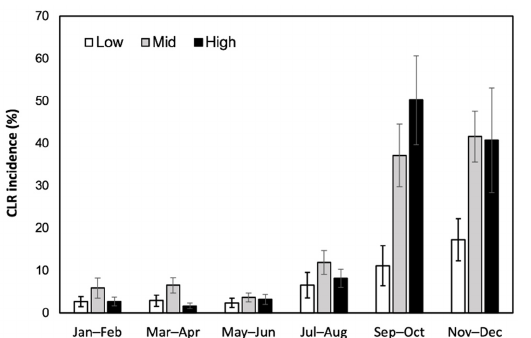
Figure 4. Mean CLR incidence across low- (200–400 m), mid- (401–600 m), and high-elevation (601–900 m) coffee lots in Kona from January–December 2021. Although a trend of lower incidence at low elevations was observed at the end of the season, this difference was not significant due to uneven sample size.